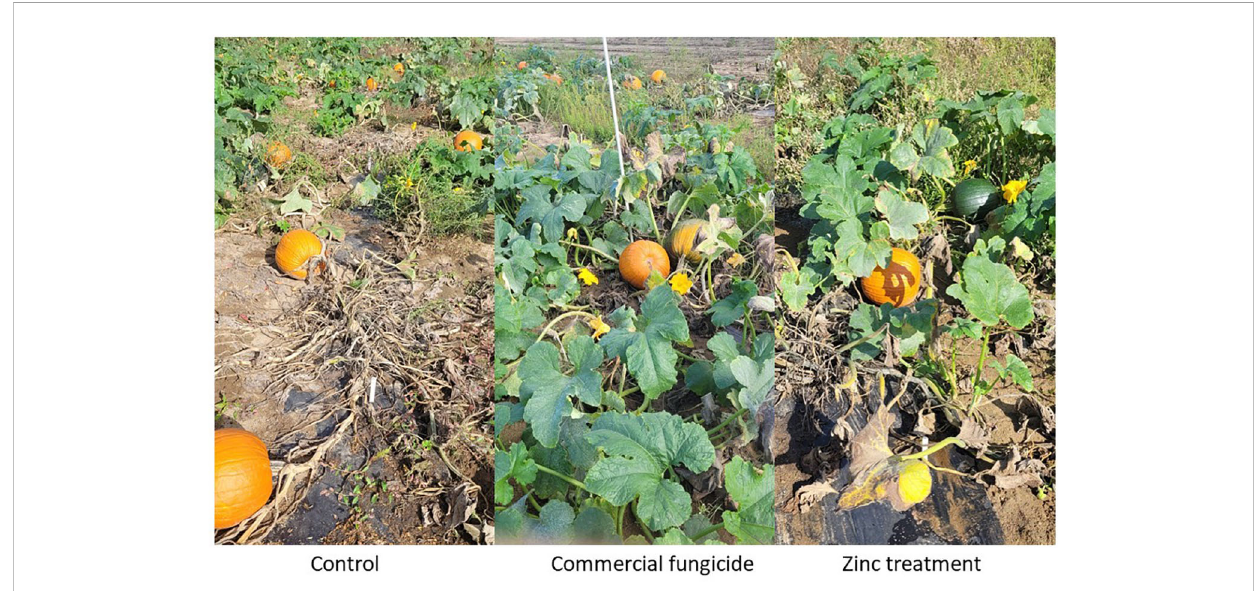
FIGURE 4 Effect of zinc treatment on watermelon vegetative and reproductive productivity (image courtesy Dr. Wade Elmer,